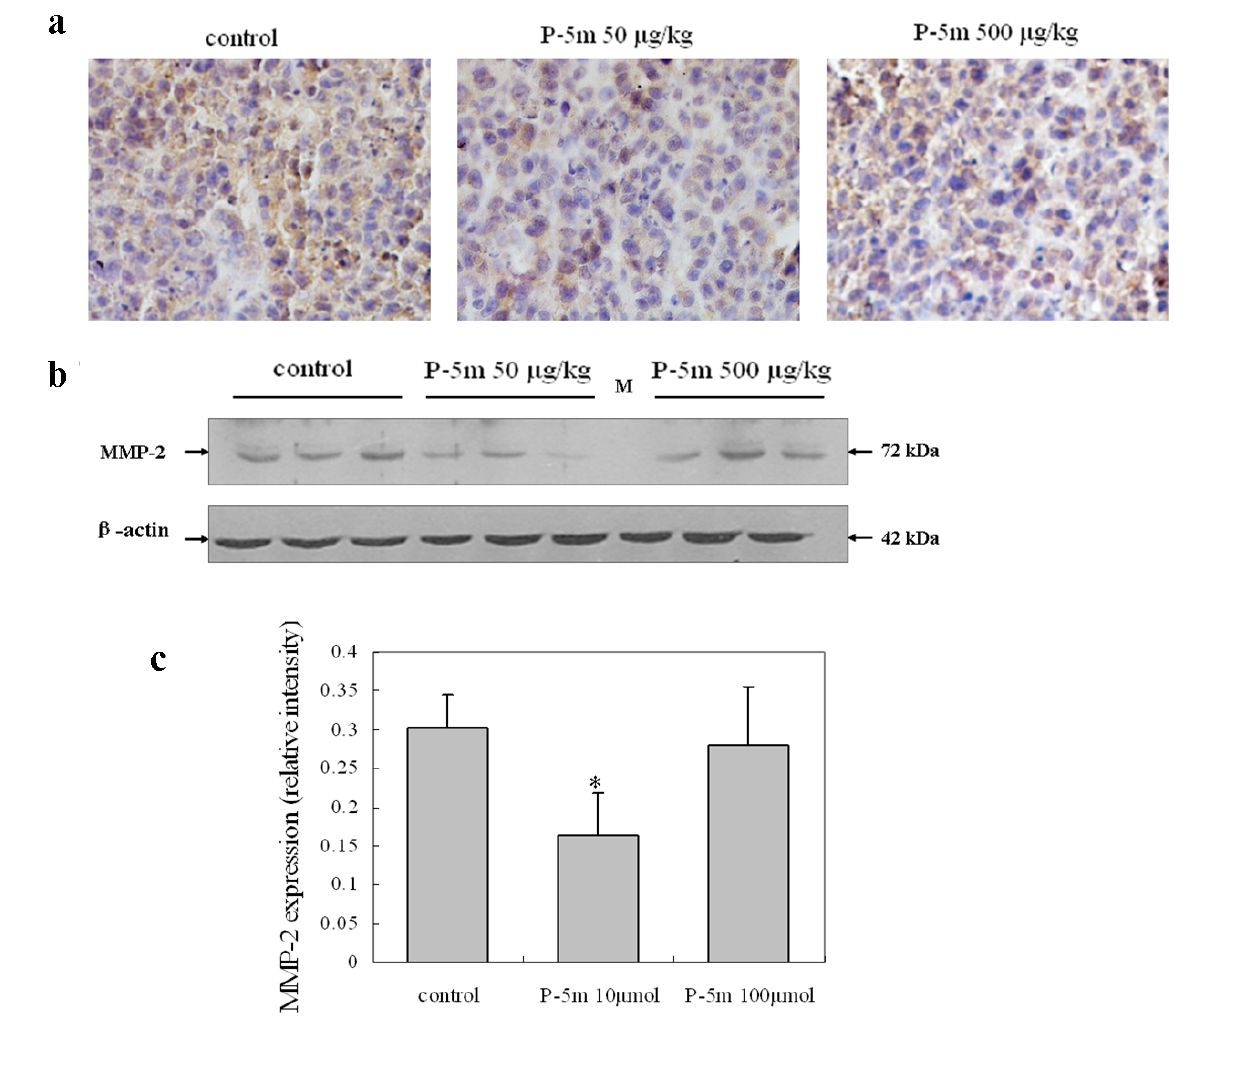
Figure 5. Effects of P-5m on MMP-2 expression in the HCCLM3 xenograft